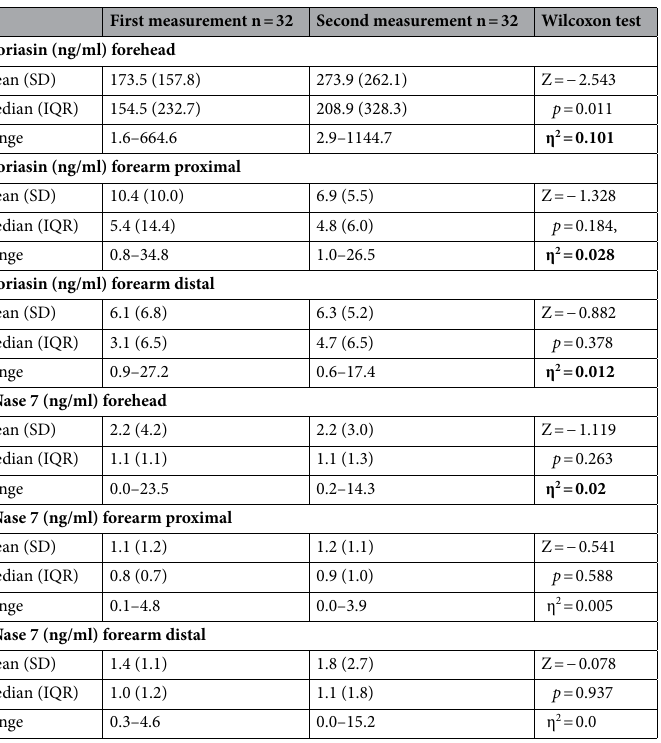
Table 3. Comparison between the first and the second measurement after weight gain in patients with anorexia nervosa (AN). η 2 eta squared, bold print indicates a small to moderate effect size. SD standard deviation, IQR interquartile